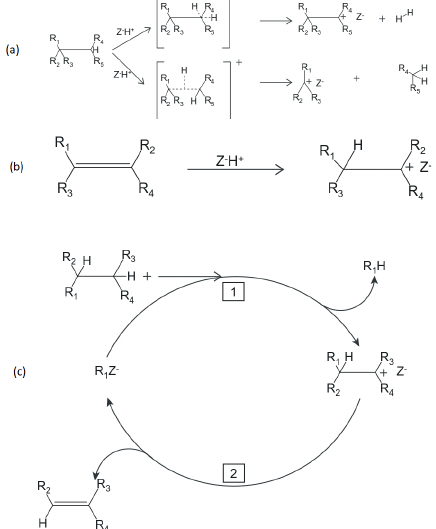
Figure 2. ( a ) Haag – Dessau mechanism for initiation of paraffin, (Adapted from [66]) ( b ) initiation mechanism of olefins, ( c ) propagation mechanism involving carbenium ions (1: Hydride transfer, 2: β -scission) (Adapted from.